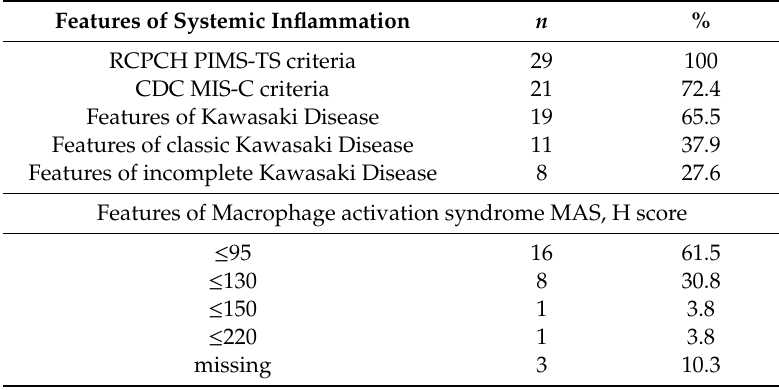
Table 2. Correlation of symptoms in children with paediatric multisystem inflammatory syndrome temporally associated with SARS-CoV-2 with symptoms of Kawasaki Disease and macrophage activation